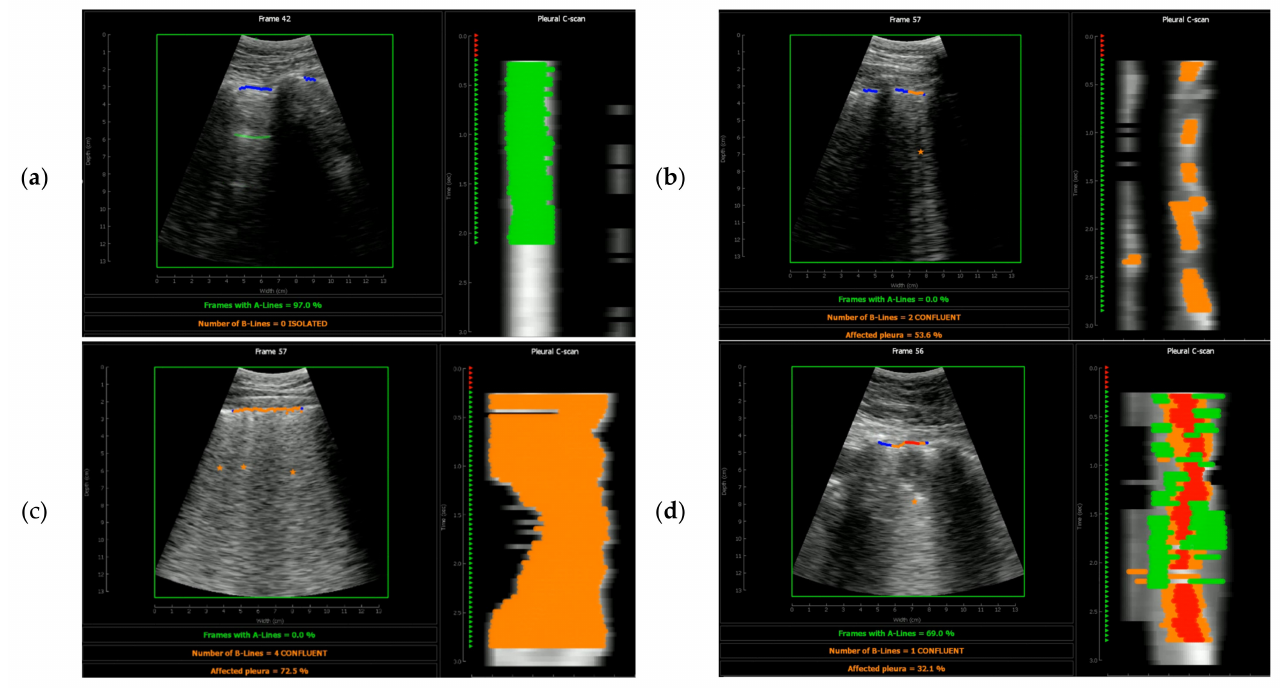
Figure 2. Output of the automatic detection algorithm ( a ) normal scan, ( b , c ) B-Lines, ( d ) consolidation. Overlay colors represent A-Lines (green), B-Lines (orange), and consolidations